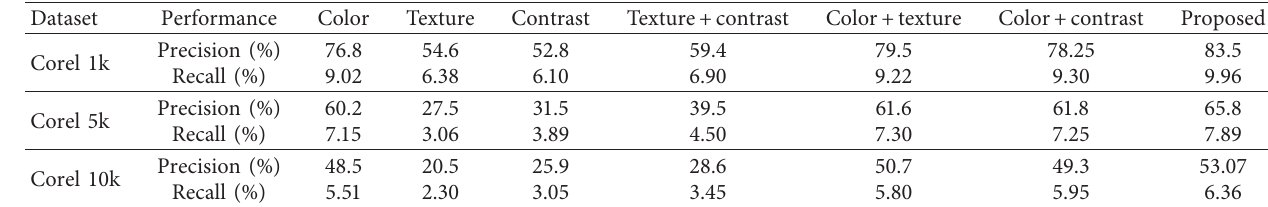
Table 6: Performance of NRLGO at Corel dataset with 1000, 5000, and 1000 images at different combinations of color, gradient orientation, and local contrast information vector. Dataset